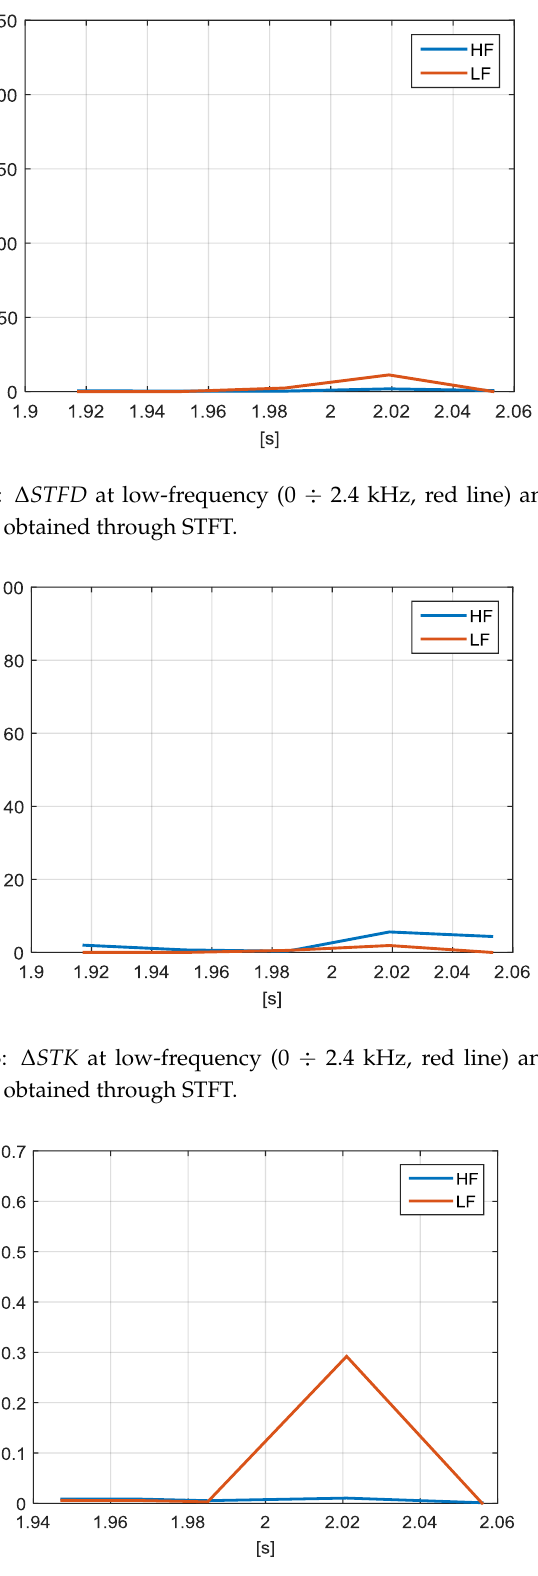
Figure 37. Case study 3: STDE at low-frequency (0 ÷ 2.4 kHz, red line) and at high-frequency (2.4 ÷ 150 kHz, blue line) obtained through STFT.